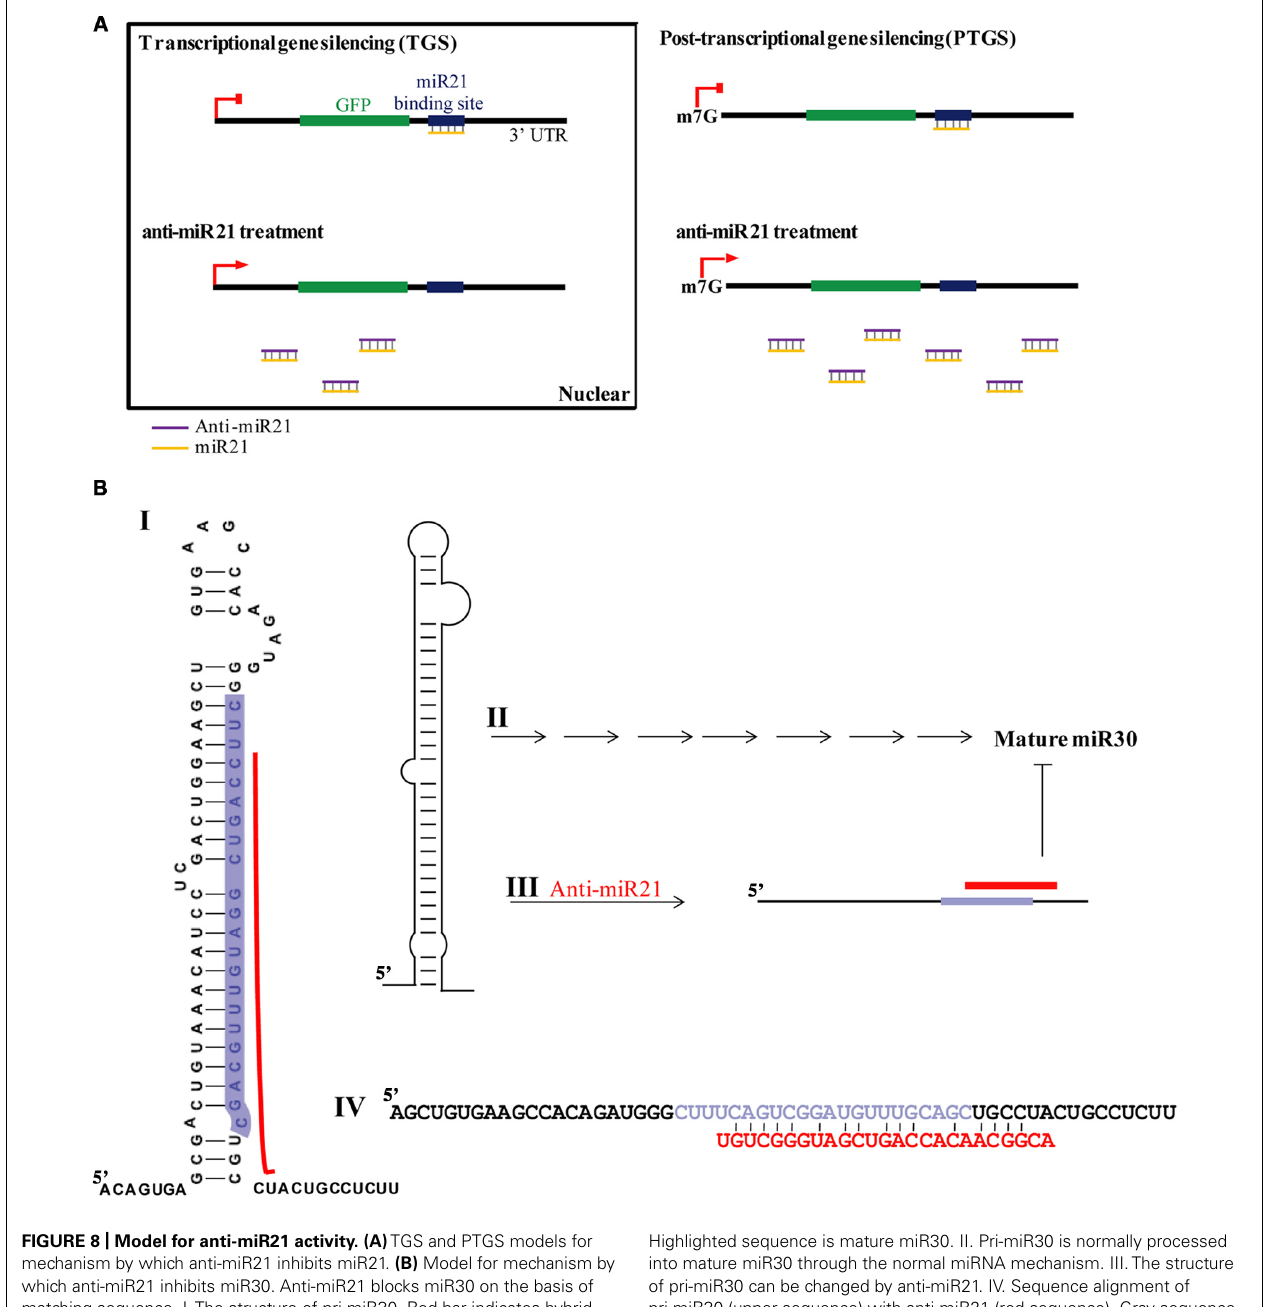
FIGURE 8 | Model for anti-miR21 activity. (A) TGS and PTGS models for mechanism by which anti-miR21 inhibits miR21. (B) Model for mechanism by which anti-miR21 inhibits miR30. Anti-miR21 blocks miR30 on the basis of matching sequence. I.The structure of pri-miR30. Red bar indicates hybrid area of anti-miR21, as identified by CLC Bio MainWorkbench software.